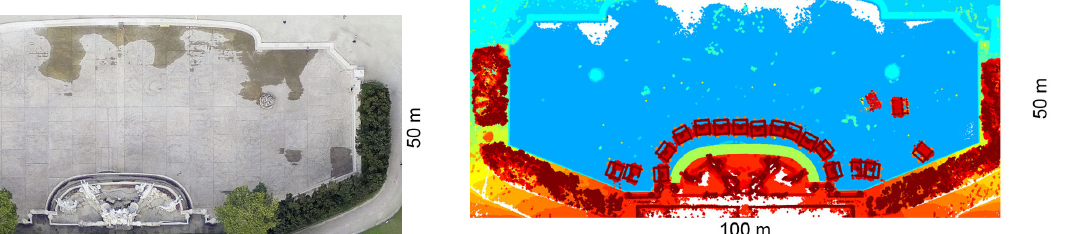
Figure 3. Height coded, reduced point-cloud of the entire scene. The main basin (blue), the cascade basins and the sculpture ensembles (bottom) and the positions of the scaffold (dark red, arranged around the cascade basins) can be seen